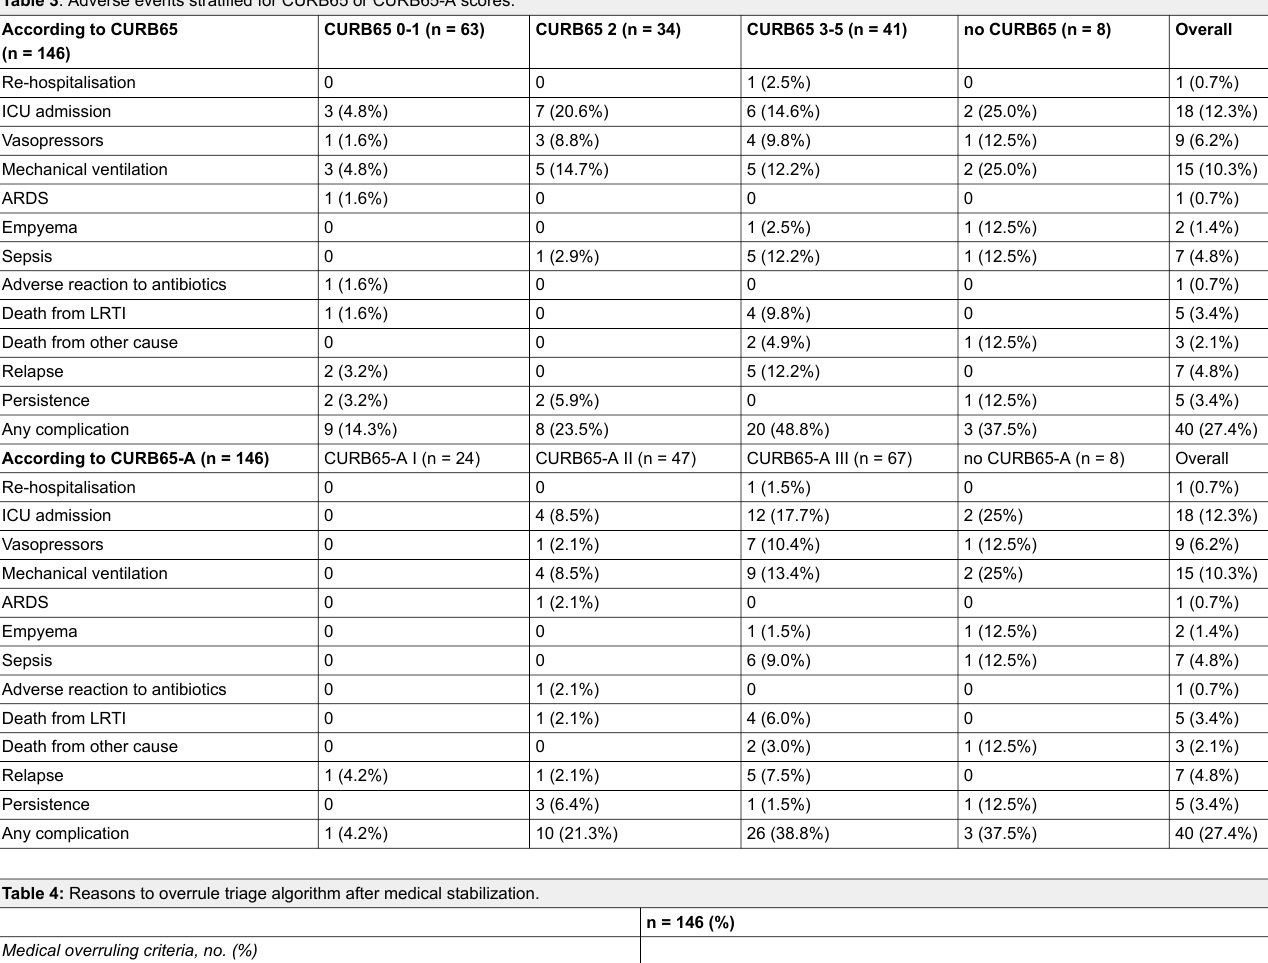
Table 3 : Adverse events stratified for CURB65 or CURB65-A scores. According to CURB65 (n = 146)